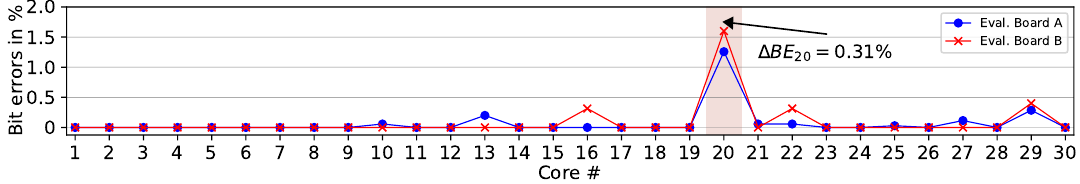
Figure 10. Bit errors across different PUF core instances and Evaluation Boards A and